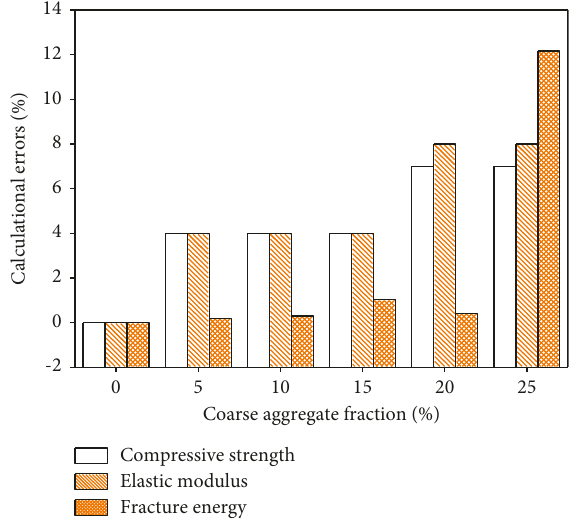
Figure 11: Calculated error